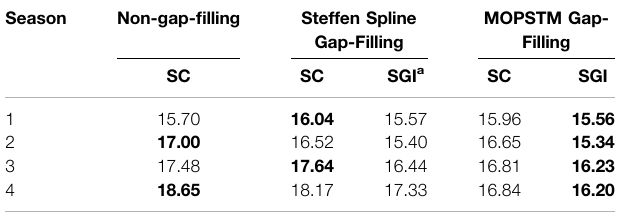
TABLE 4 | The median RMSE of seasonal composites (using non-gap- fi lling, Steffen spline gap- fi lling, and MOPSTM gap- fi lling) and seasonal gap- fi lled images by Steffen spline and MOPSTM methods for modelling tree canopy cover. Thehighestandlowestvaluesarepresented inbold.Abbreviations:SGI:seasonal gap- fi lled